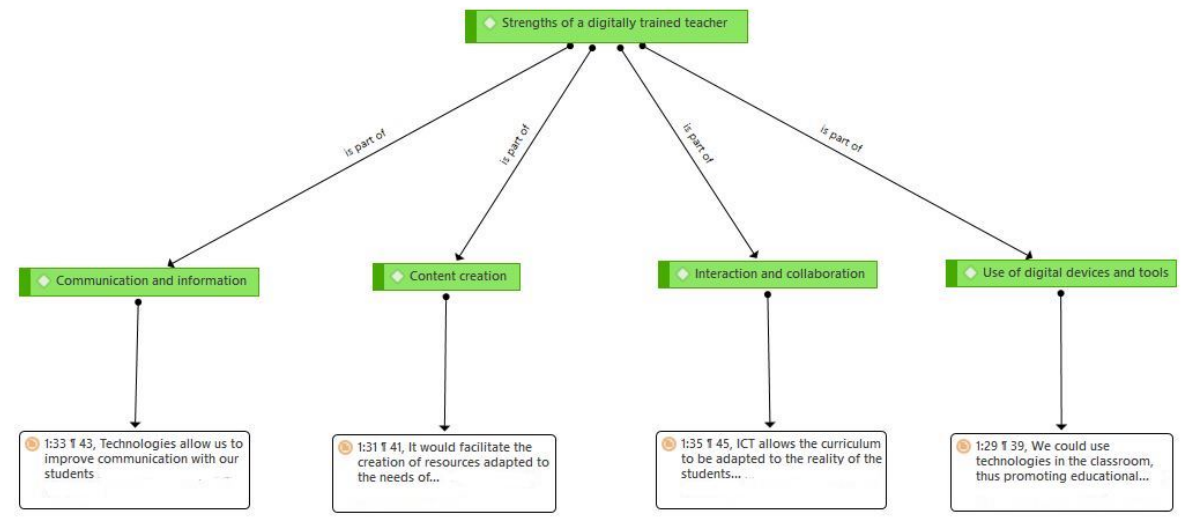
Figure 4. Semantic network with empirical evidence of the category “Strengths of a digitally trained teacher”.